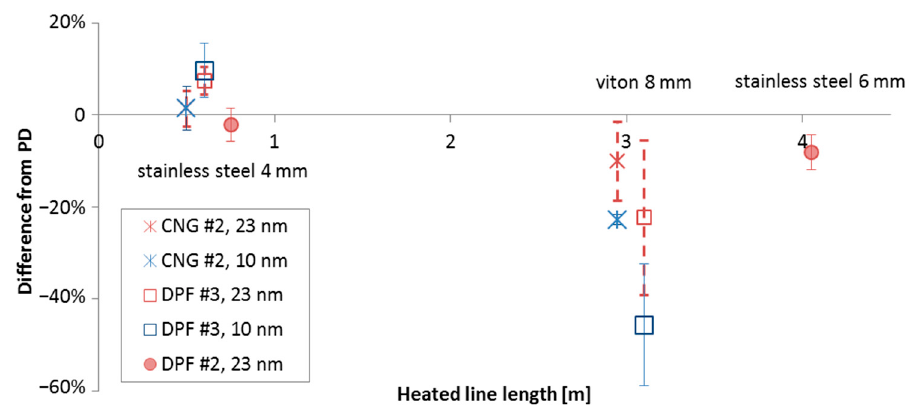
Figure 2. Di ff erences of the “Golden” TP(CS) system to the OEMs’ PD(ET) systems for di ff erent lengths Figure 2. Differences of the “Golden” TP(CS) system to the OEMs’ PD(ET) systems for different of the heated (150 ◦ C) line upstream of the “Golden” lengths of the heated (150 °C) line upstream of the “Golden” system.